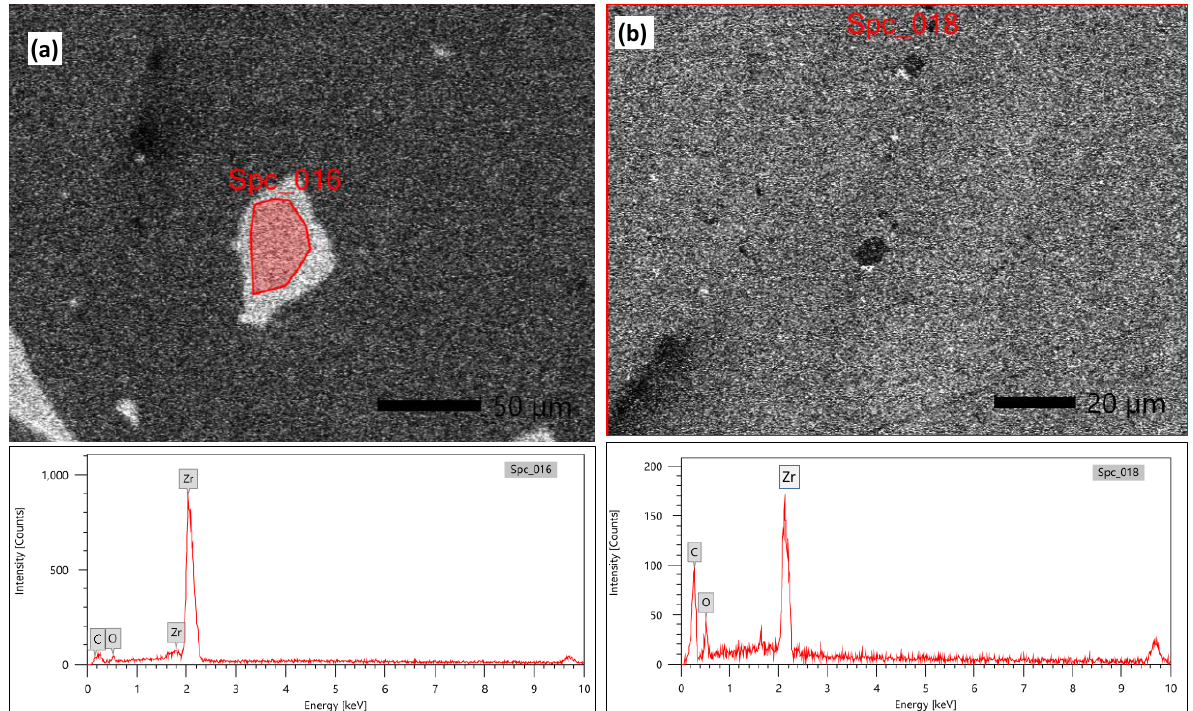
Figure 8. The EDS analysis of the micro-sized particle is presented in ( a ) and the EDS of the nano- composite ( b ).